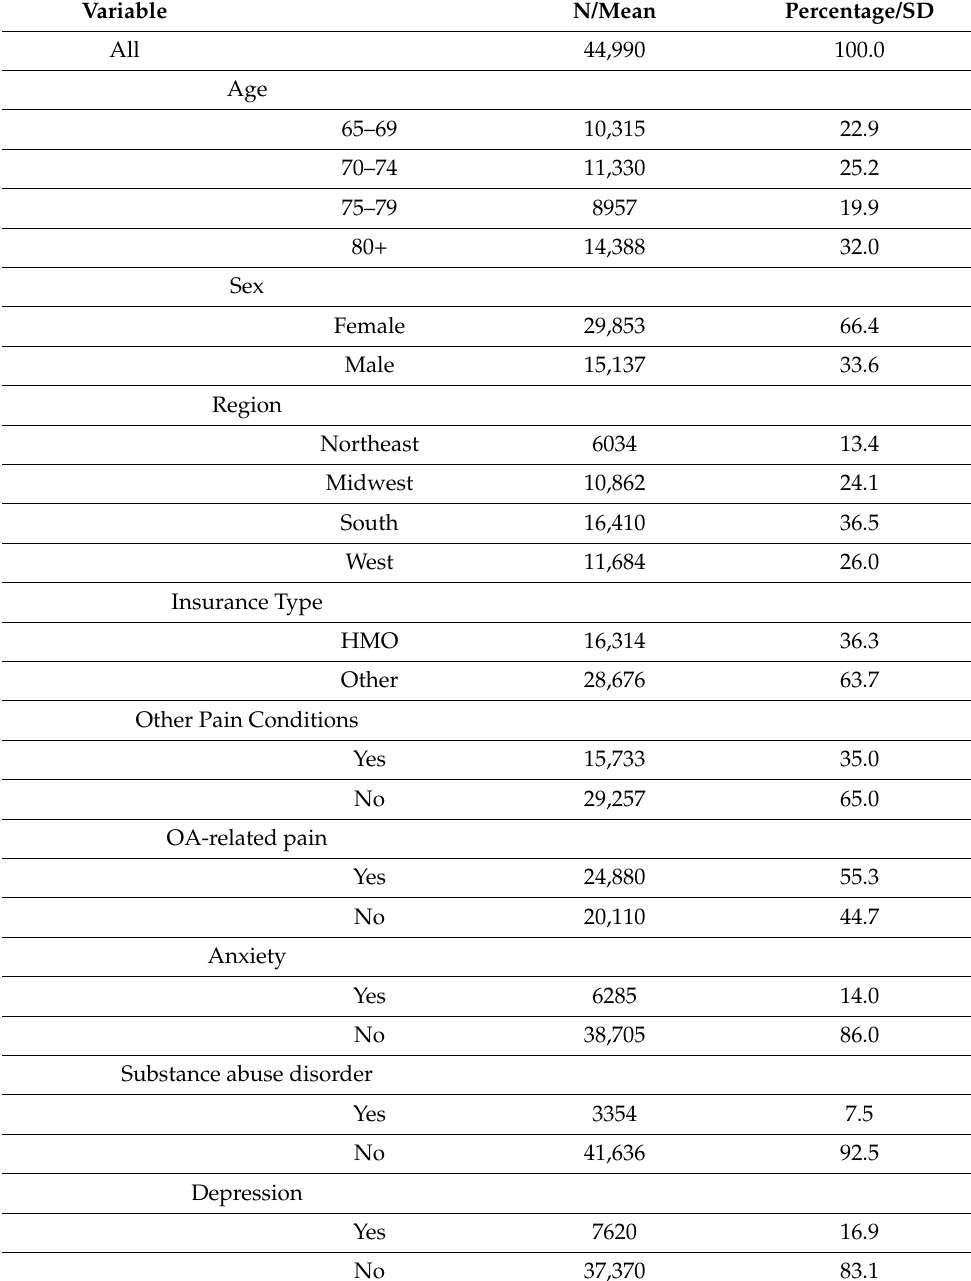
Table 2. Selected Sample Characteristics; Older Adults (age > 65) with Osteoarthritis ( n = 44,990); Optum Clinformatics Data Mart